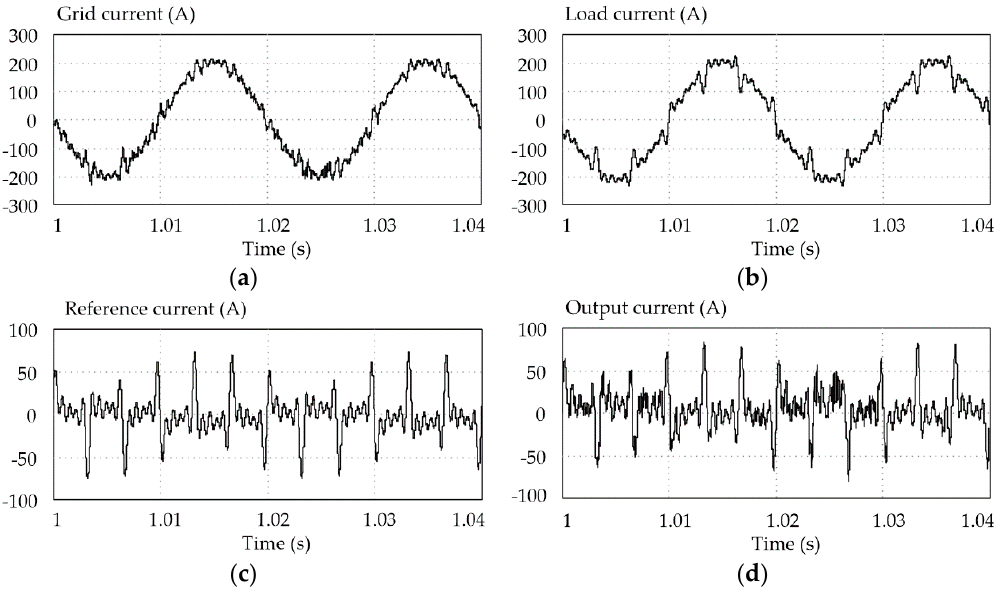
Figure 10. Simulation result without reference compensation. ( a ) grid current; ( b ) load current; ( c ) reference current; ( d ) output current.